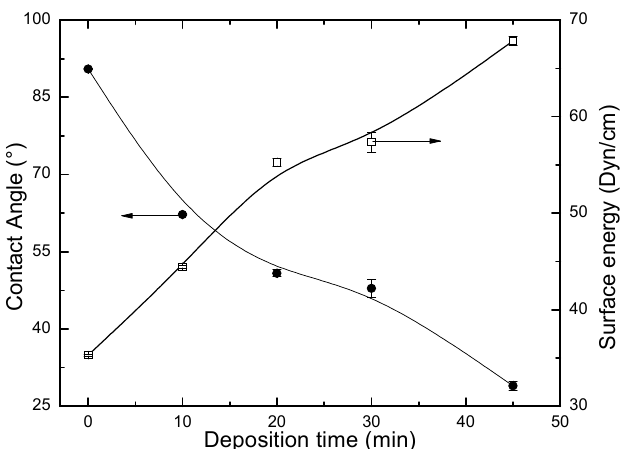
Figure 6. Water contact angle and surface energy of the plasma deposited carvacrol films as a function of deposition time. The values indicated at t = 0 correspond to results measured with the substrates exposed to the monomer with the plasma off.